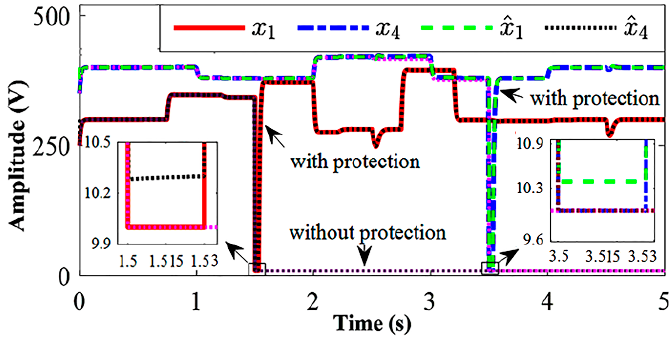
Figure 10. Capacitance C 1 and C 4 voltage during fault occurrence.